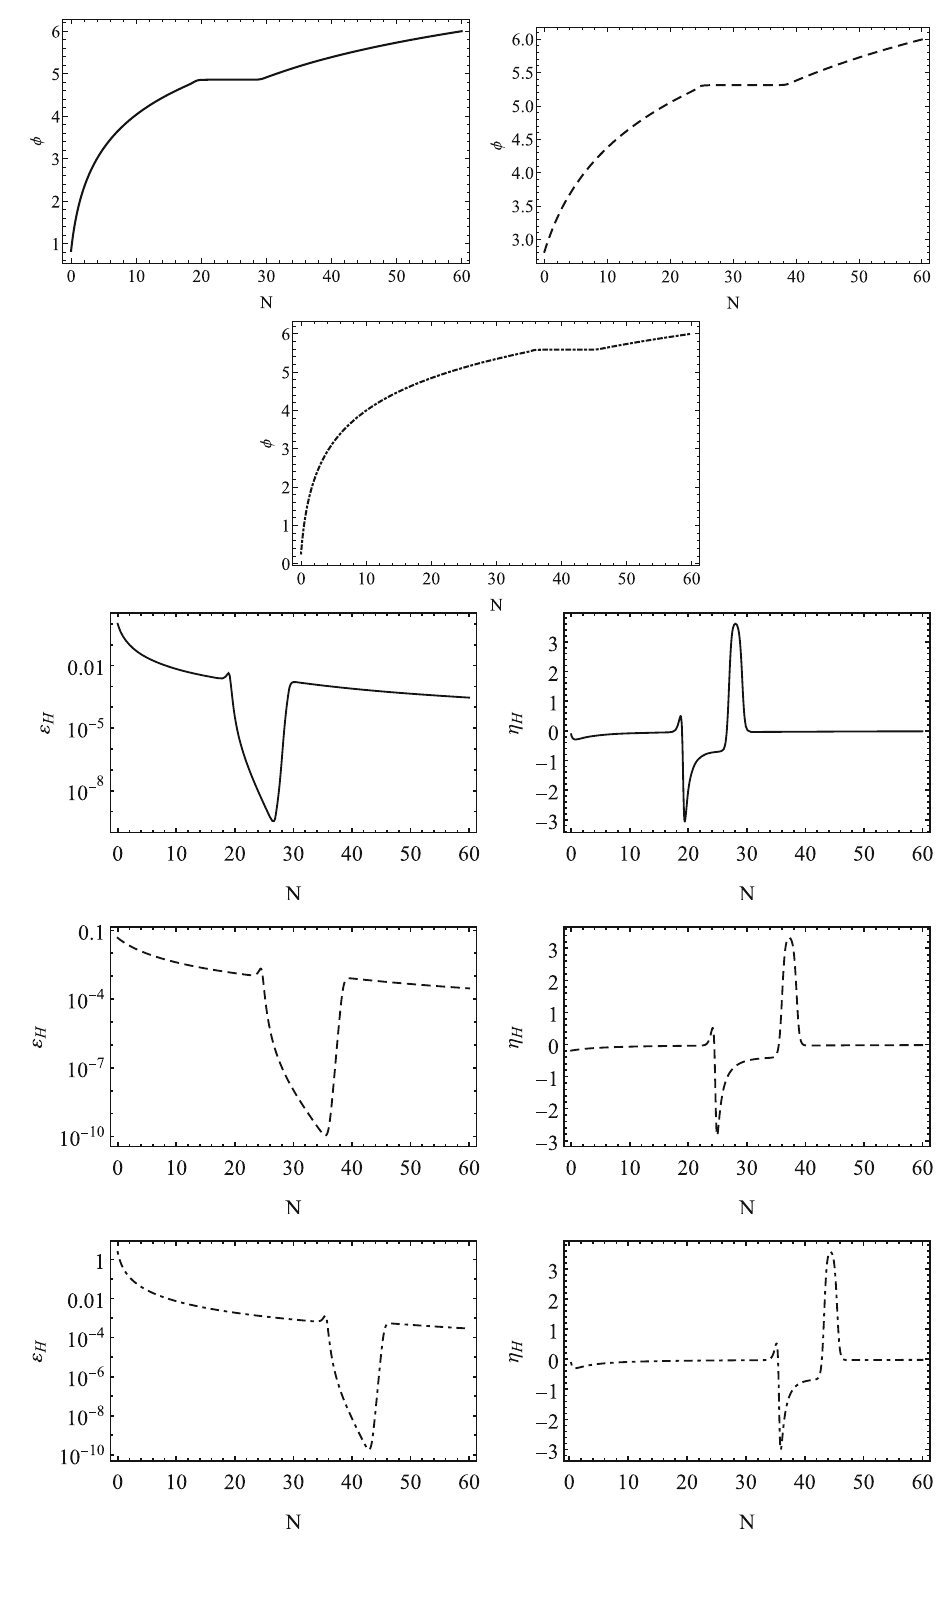
Fig. 1 Evolution of the scalar field φ as a function of the e -fold number N for Case 1 (solid line), Case 2 (dashed line), and Case 3 (dash-dotted line)